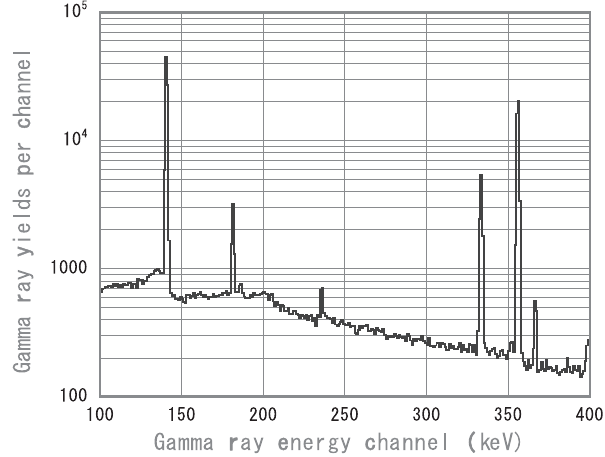
FIG. 3. Energy spectrum of (cid:1) rays from natural Mo sample with 0.074 of Au in weight. The 140.5 and 181 keV lines are from 99 Mo decays and 333 and 356 keV lines are from 196 Au